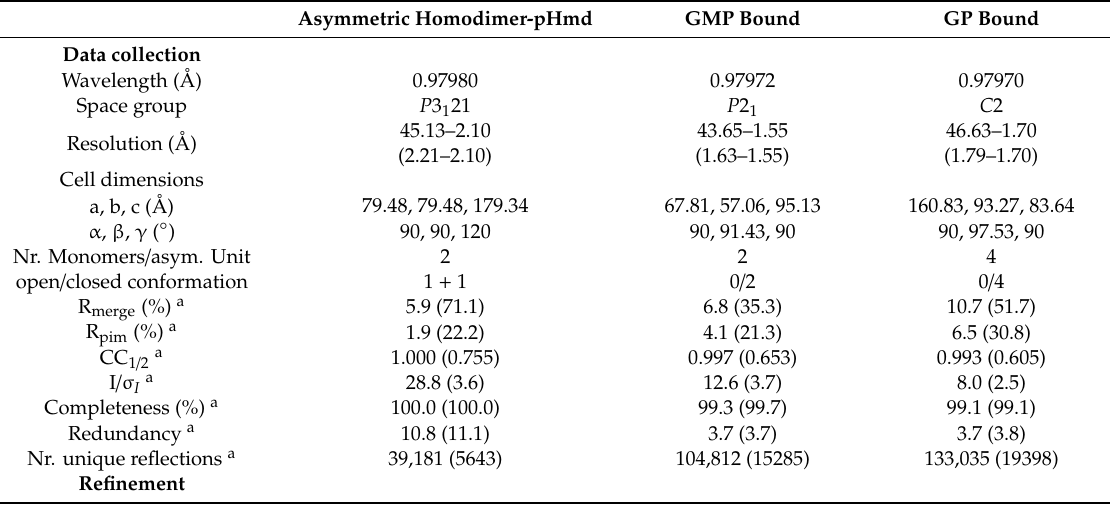
Figure 2. Crystal structure of the asymmetric homodimer of pHmd. ( a ) Overview of the asymmetric homodimer of pHmd. One monomer (left) is the apo-form and the second monomer (right) is bound to the FeGP cofactor. ( b ) Comparisons between the apo-form of the asymmetric pHmd homodimer (orange) and apo-form of jHmd (pink, PDB: 2B0J). The chain from the next monomer of pHmd in the central domain is distinguished by the green color. ( c ). Comparison between the holo-form of the asymmetric pHmd homodimer (green) and holo-form of jHmd (blue, PDB: 3F47). The chain from the next monomer of pHmd in the central domain is distinguished by the orange color. The FeGP cofactor is shown by ball and stick models. For both pictures in ( b , c ), the N-terminal domain is superposed. Table 1. X-ray analysis statistics.